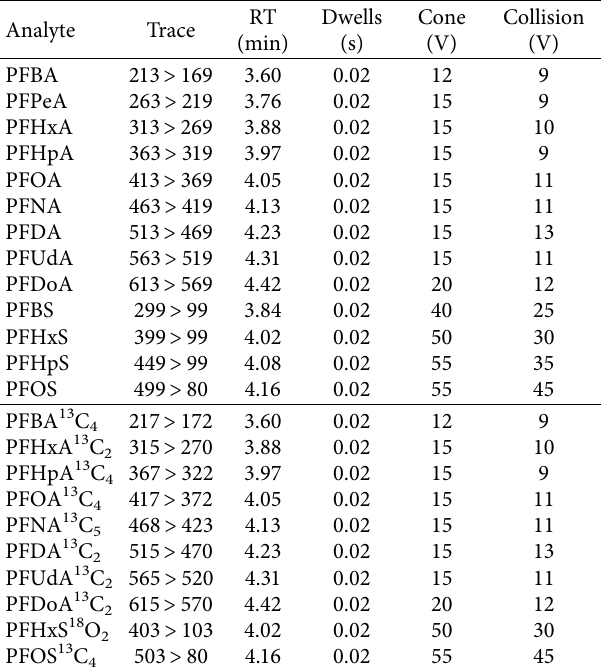
Table 3: Acquisition